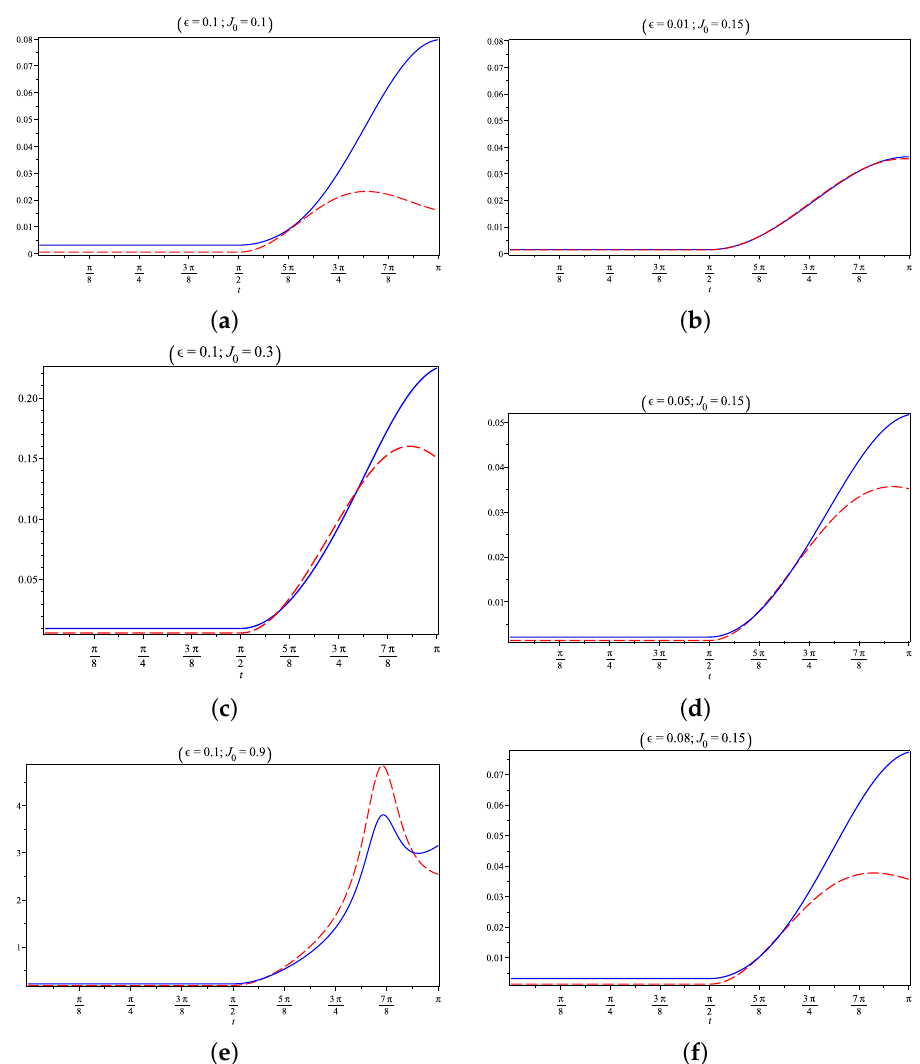
Figure 9. Effects of coupling J 0 (first column) and quench parameter (cid:101) (second column) on the hierarchy of VE in both modes. The red dashed line corresponds to (cid:104) N 1 ( t ) (cid:105) and the blue solid line to (cid:104) N ( t ) (cid:105) , while ω 2 = 2 0